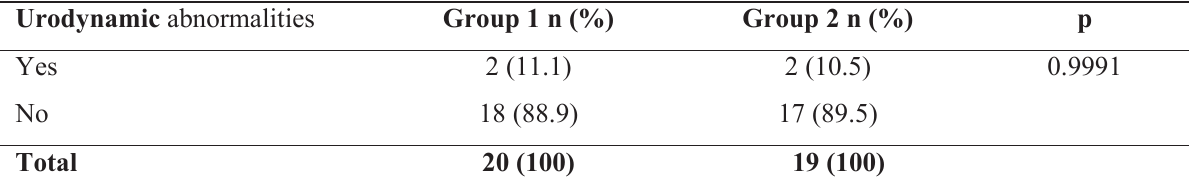
Table 5 - Presence of urodynamic abnormalities on postoperative day 90 after sling surgery for the treatment of stress urinary incontinence.